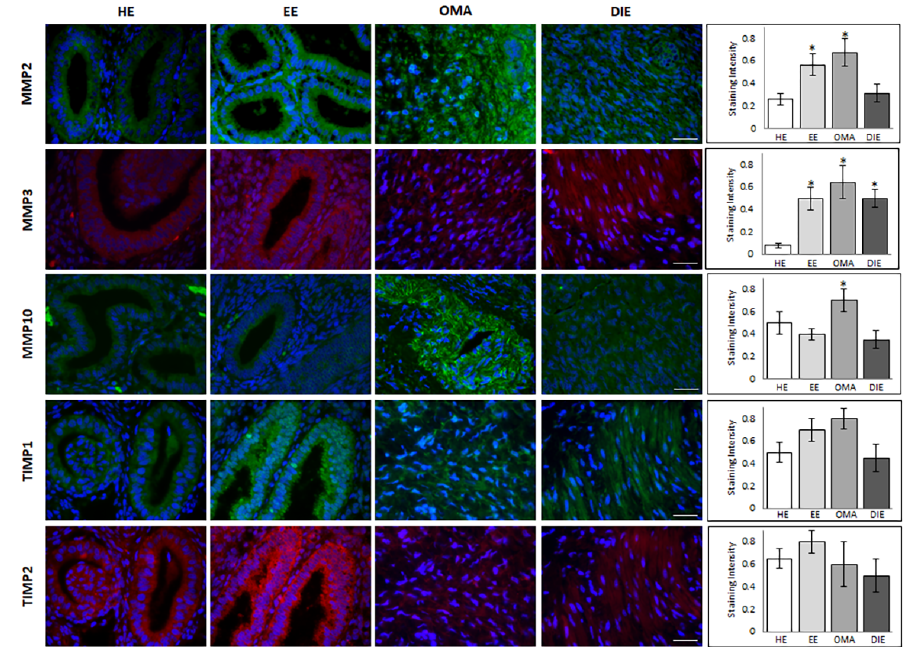
Figure 3. Representative images of immunofluorescence staining of MMPs and their inhibitors in healthy (HE), eutopic (EE) endometrium, in endometrioma (OMA), and in deep infiltrating lesion (DIE). MMP2 (green), MMP3 (red), MMP10 (green), TIMP1 (green), and TIMP2 (red). Nuclei were counterstained with DAPI (blue). Scale bar = 25 mm. Right histograms show the intensity of staining of MMPs and their inhibitors in HE, EE, OMA, and DIE. Data are represented as mean ± SD. * p < 0.05.